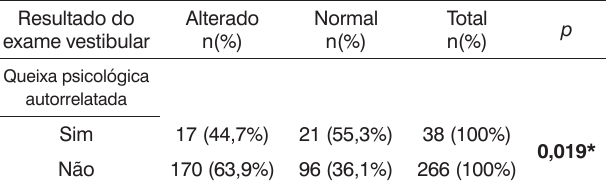
Tabela 5. Associação entre resultado do exame vestibular e presença de queixa psicológica autorrelatada na amostra (Teste